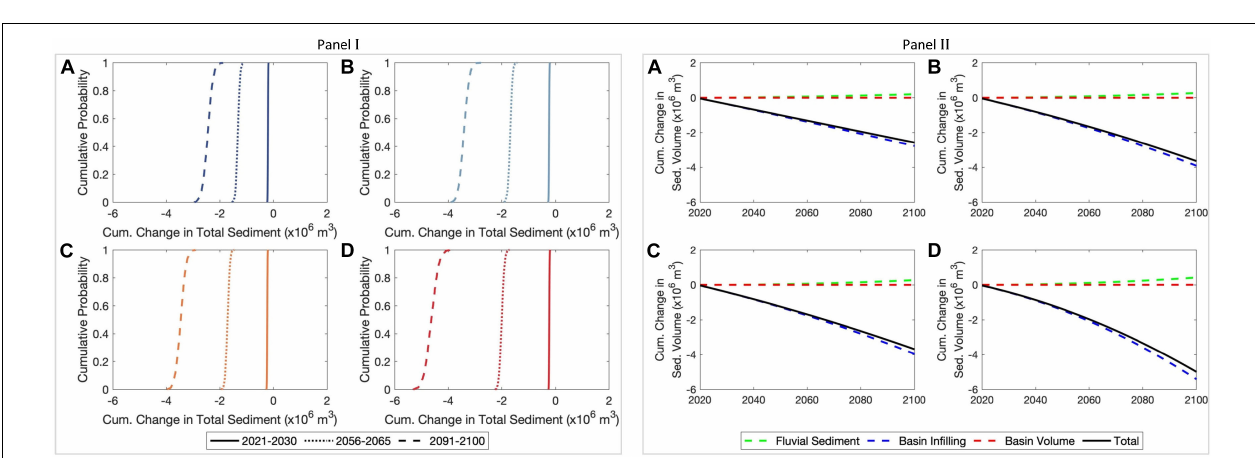
FIGURE 8 | Projected variation of change in total sediment volume exchange ( (cid:49) V T ) between the Dyfi estuary and the adjacent coast over the 21 st century. The projected ranges between 10 th and 90 th percentile are shown as shaded bands with the variation of the 50 th percentile values indicated by the solid lines for RCP 2.6 (blue) and RCP 8.5 (red). The negative volumes indicate that the estuary traps more sediment at the expense of the open coast. Deterministic projections of (cid:49) V T presented in Bamunawala et al. (2020) for RCP 2.6 (blue) and RCP 8.5 (red) are indicated by the dashed lines. Vertical bars indicate the projected ranges between the 10 th and 90 th percentiles in 2100 for all RCPs with the 50 th percentile values indicated as horizontal lines.